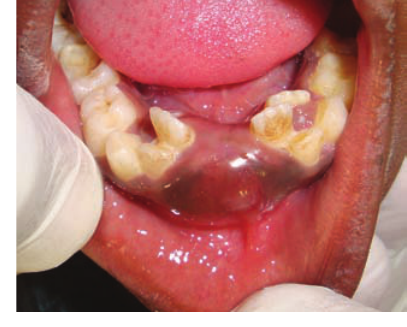
Figure 1. Clinical photograph showing the swelling in the mandibular anterior region.